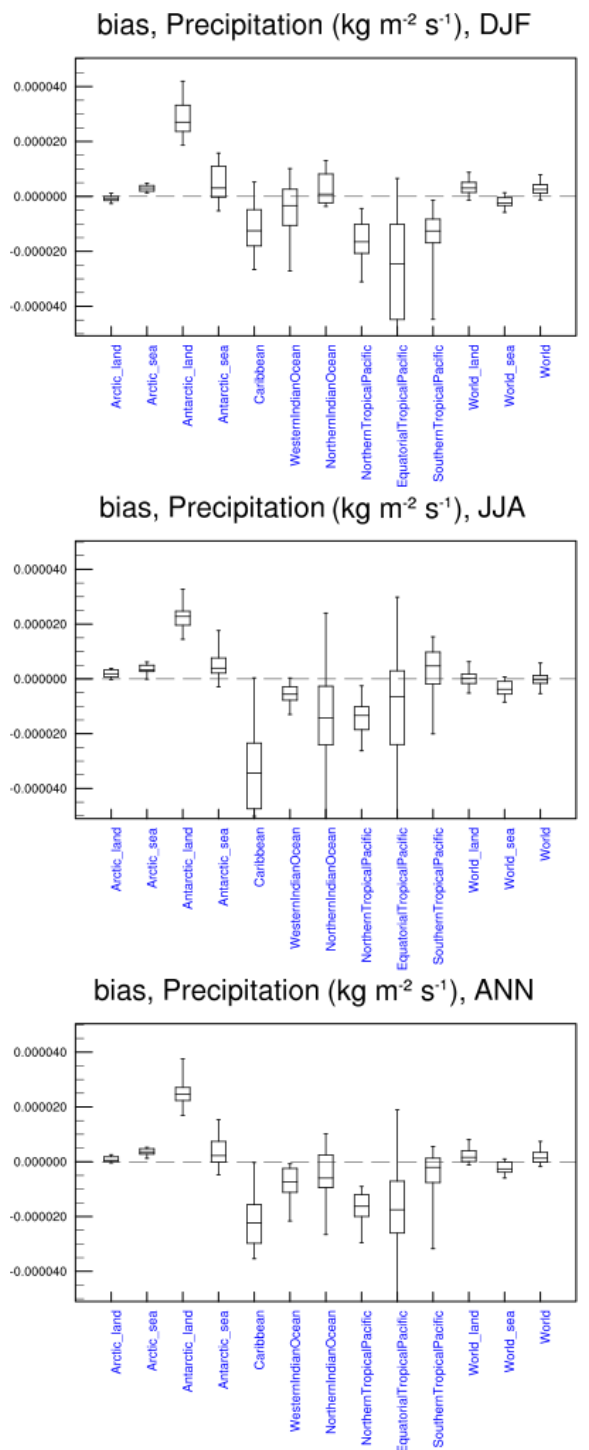
Figure 15. Box-and-whisker plots showing the 5th, 25th, 50th, 75th, and 95th percentiles of the seasonal and annual mean bi- ases for the precipitation (pr) in oceanic and polar regions between 38 CMIP5 models and CRU data. Similar to Fig. 9.40b, d, and f of the IPCC AR5 report (Flato et al., 2013) and produced with recipe_flato13ipcc.yml ; for details see Sect.